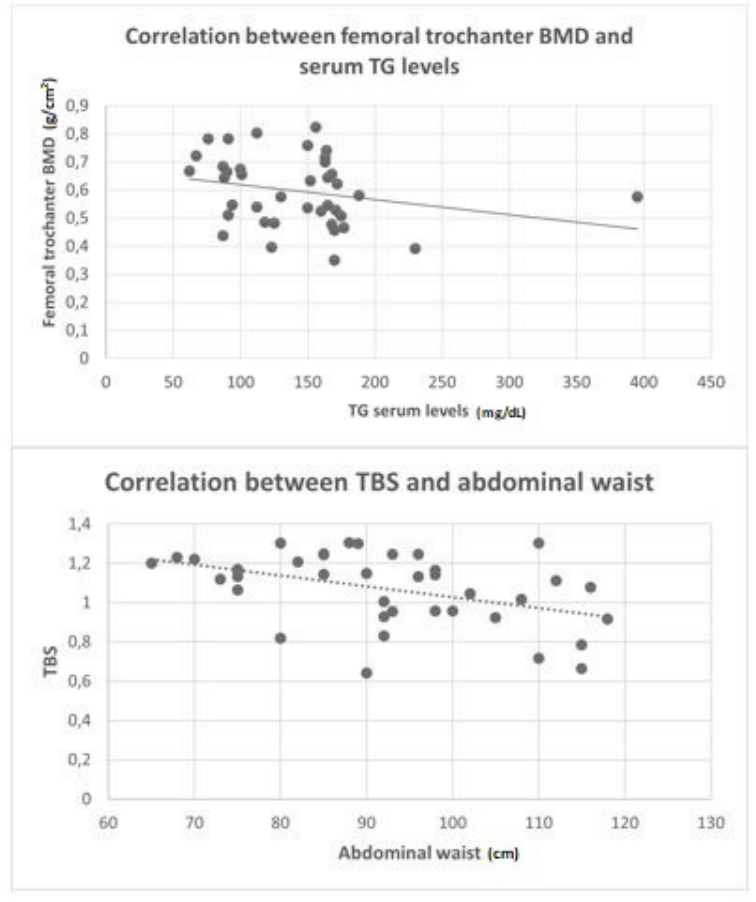
Figure 2. Correlations between femoral trochanter BMD with serum TG concentrations ( above ) and correlations between TBS with the abdominal waist ( below ). For abbreviations, see the legend of Table